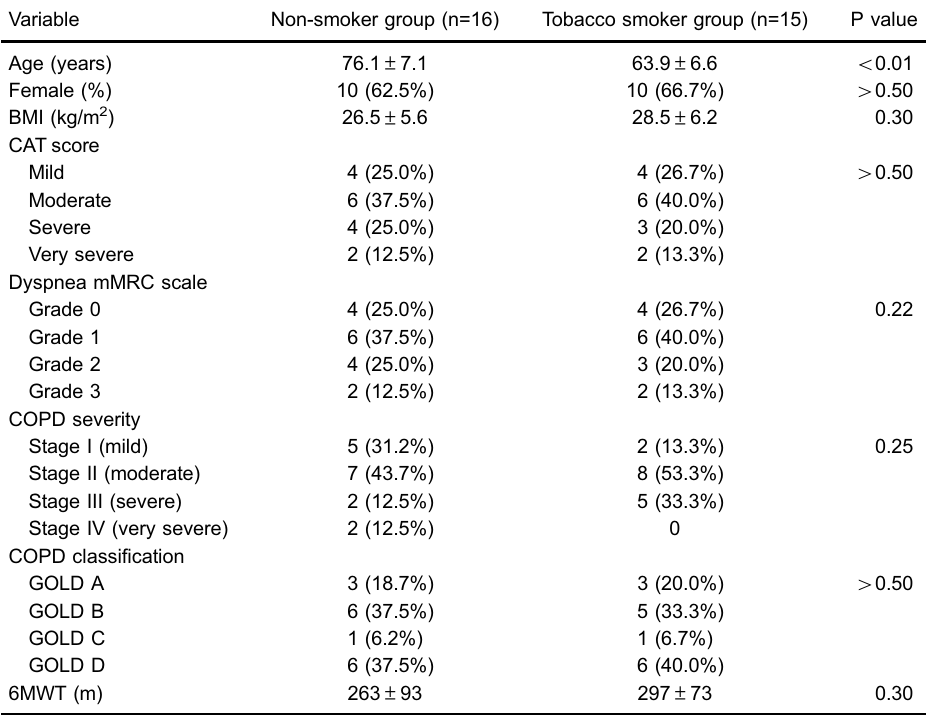
Table 1. Patient characteristics according to chronic obstructive pulmonary disease (COPD)